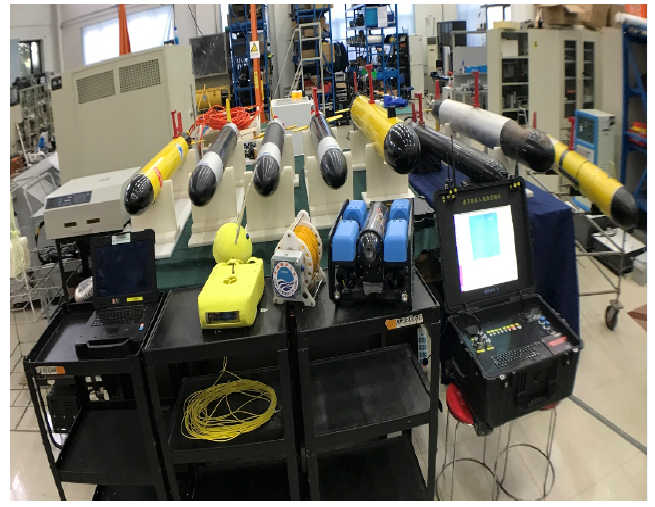
Figure 15. Sailfish AUV.